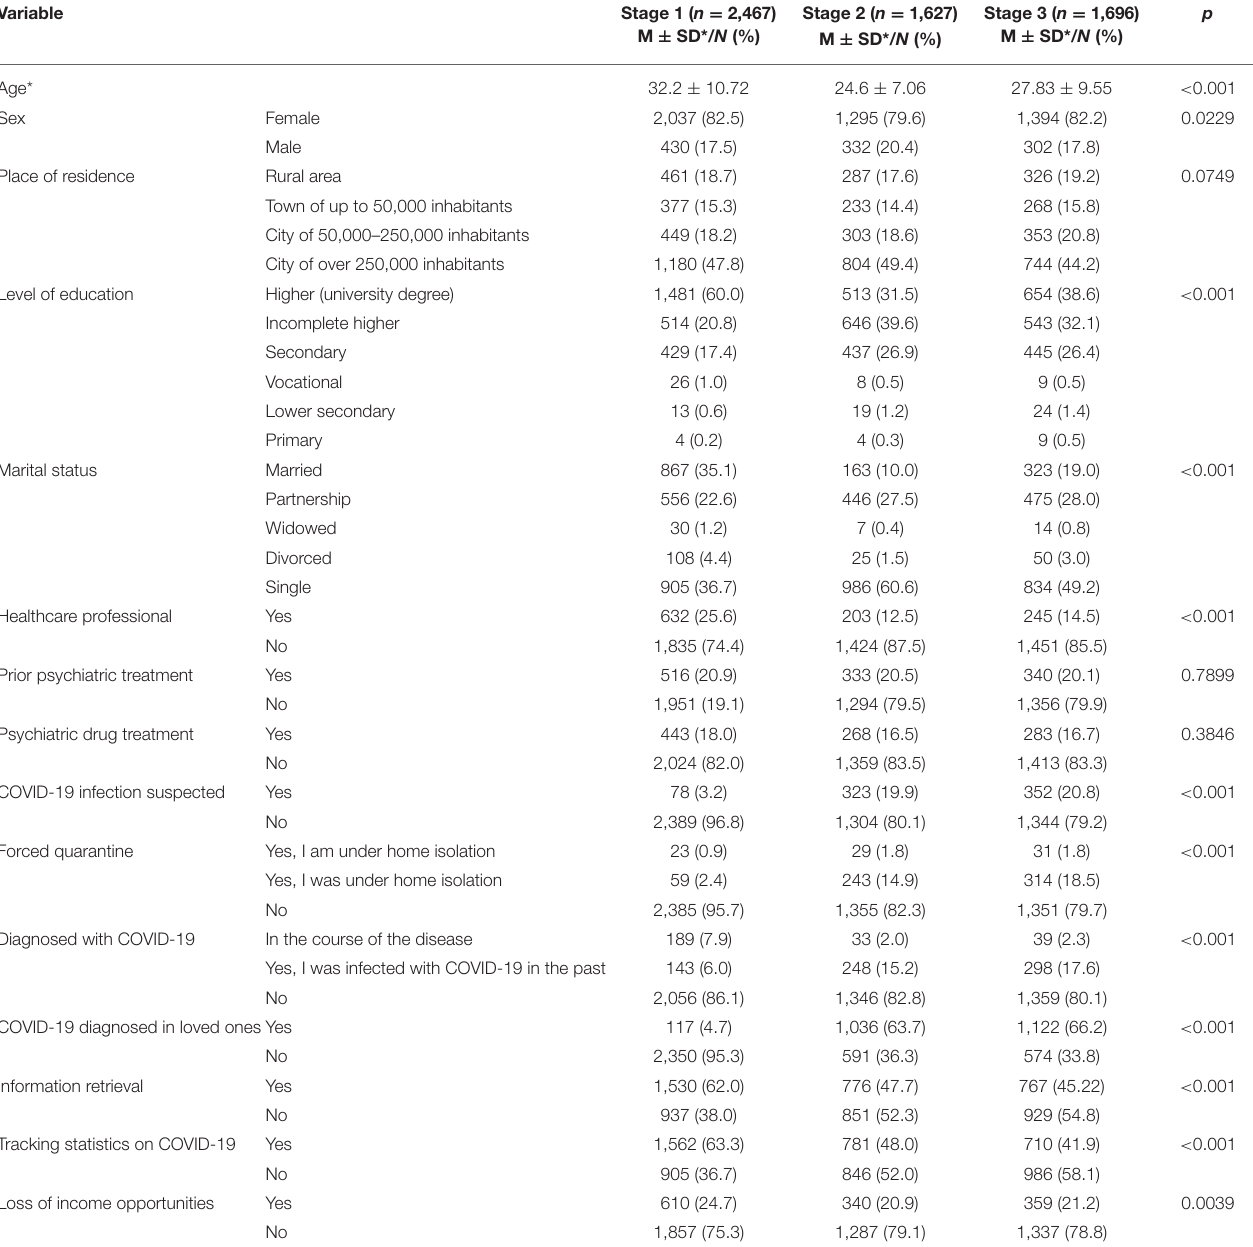
TABLE 1 | Characteristics of the study group by study stage.